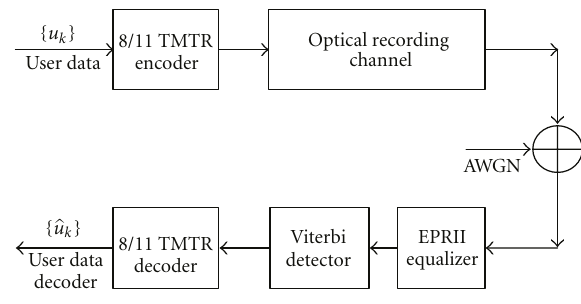
Figure 6: Optical recording system